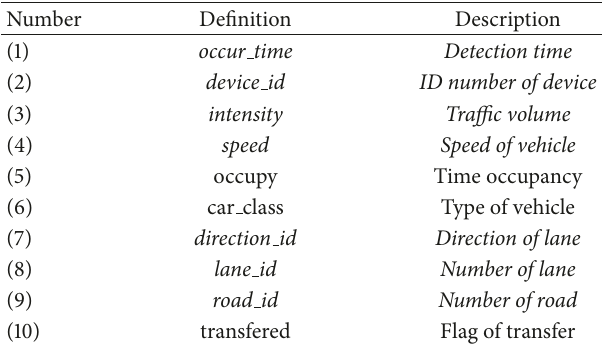
Table 1: Traffic information collected by microwave